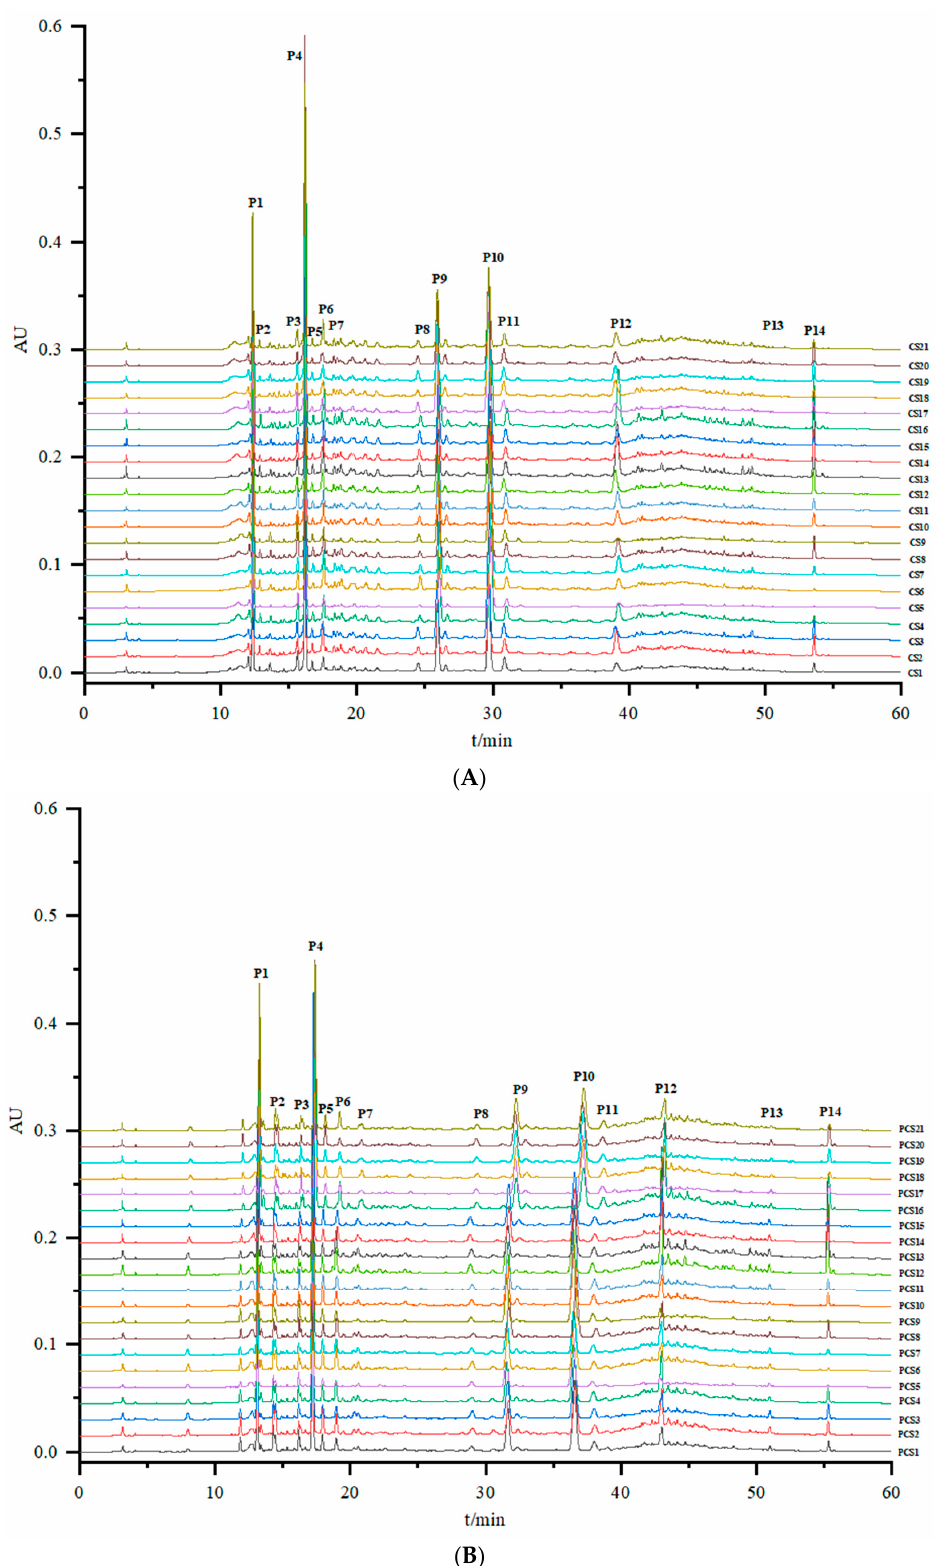
Figure 3. The chromatographic fingerprints of the 21 batches of CS ( A ) and PCS ( B ) samples.